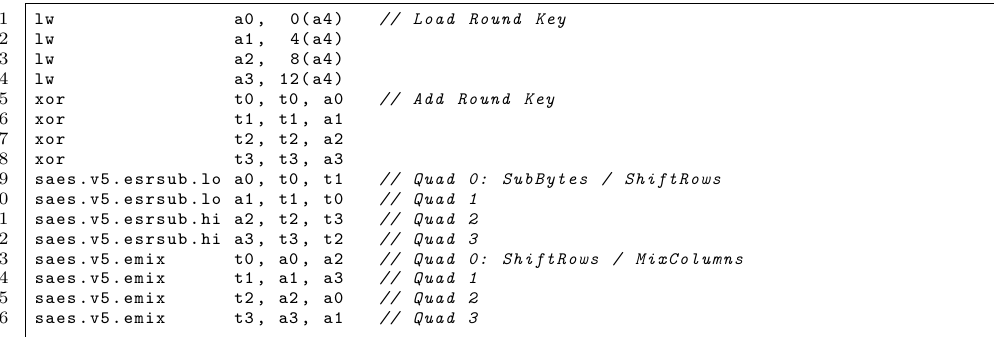
Figure 11: An AES encryption round implemented using V 5